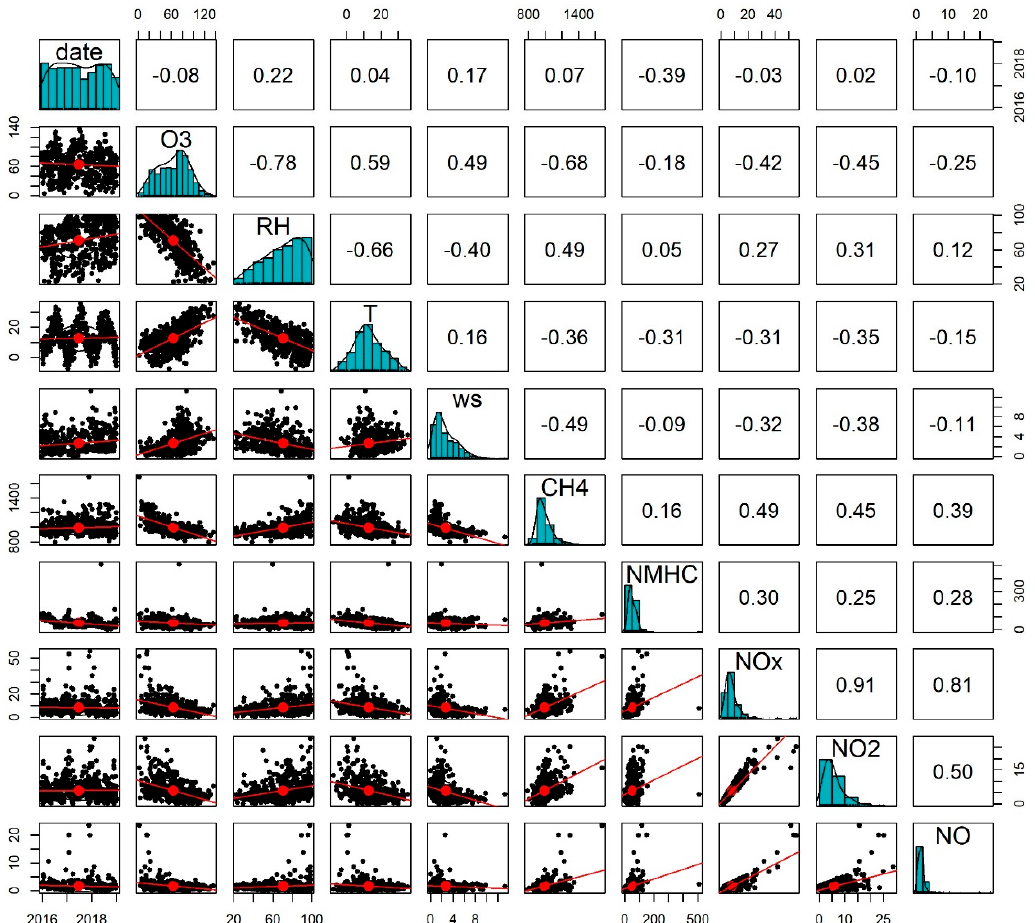
Figure 2. Correlation matrix: the upper panel above the diagonal shows the Pearson’s correlation coefficients, the lower panel below the diagonal gives their scatterplots. The histograms of the variables are shown on the diagonal.